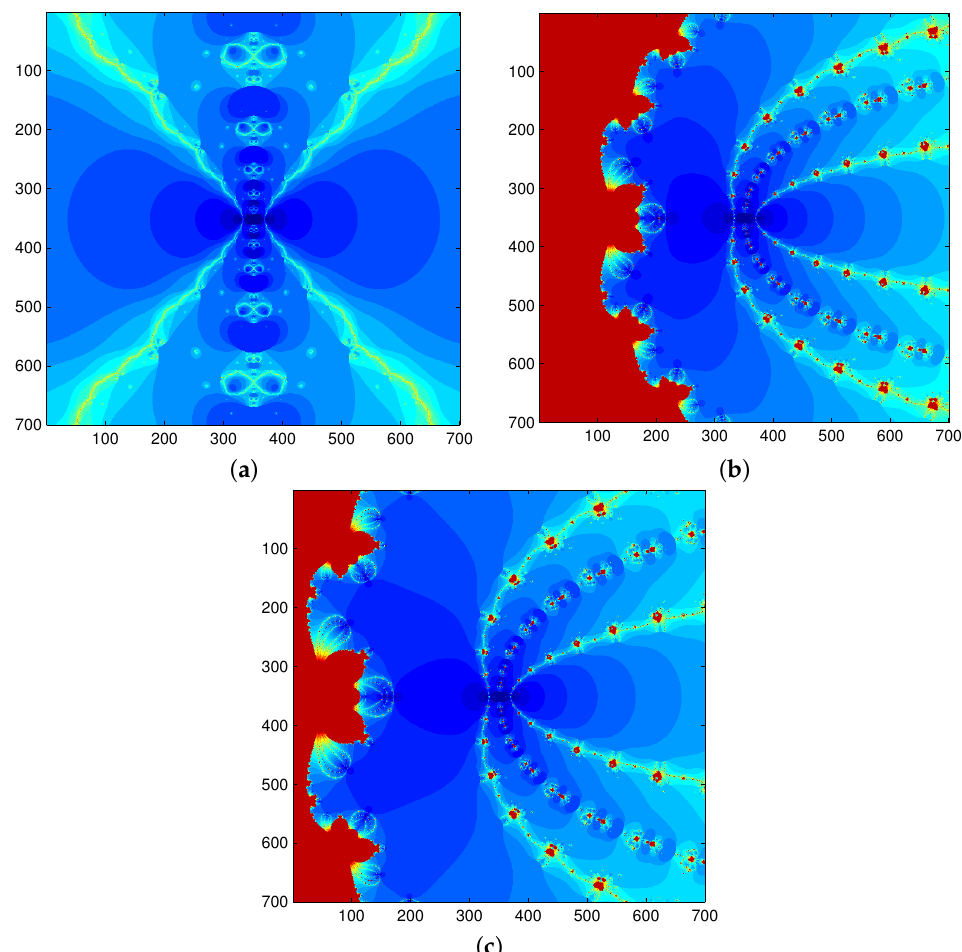
Figure 5. Dynamics of different methods for f 2 ( x ) = x 4 sin ( 1/ x ) : ( a ) Newton’s method; ( b ) Fang et al. method; ( c ) proposed